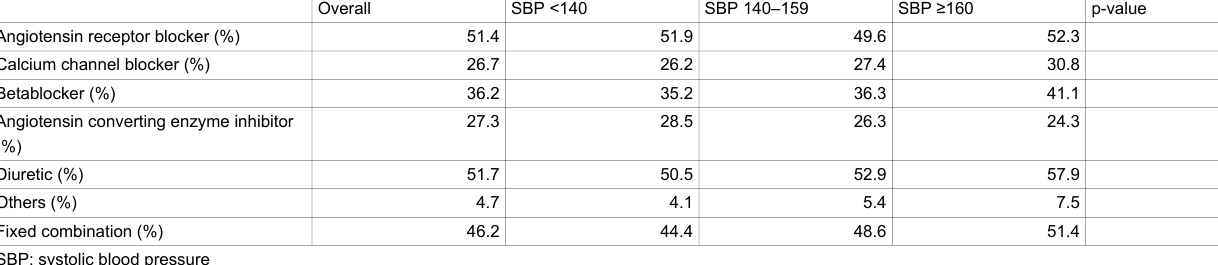
Table 5: Antihypertensive medication by systolic blood pressure subgroups.